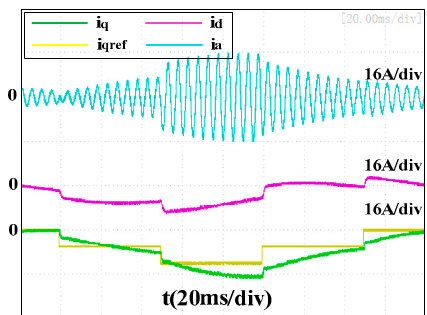
Figure 16. d-q axis current waveform of the proposed accurate discrete current controller at 6000 rpm with Kdq = 1000 π Ls.